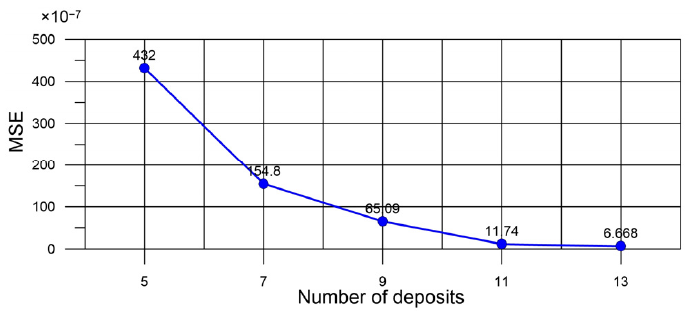
Figure 12. The MSE deviation of the TF-IDF values among different datasets.